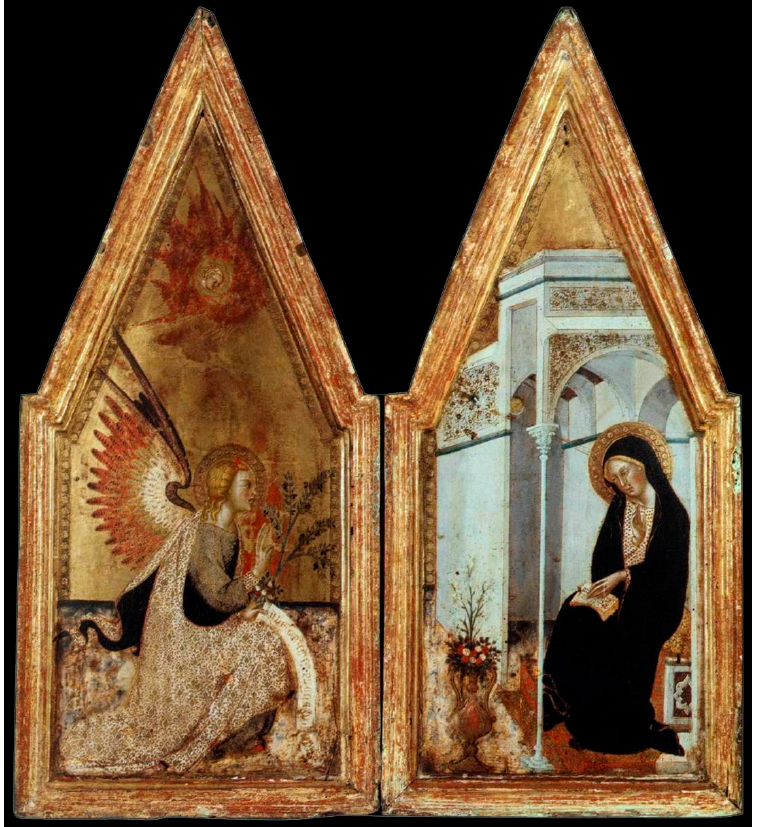
Figure 2. Andrea di Bartolo, Diptych of the Annunciation , c. 1383. Museum of Fine Arts, Budapest.